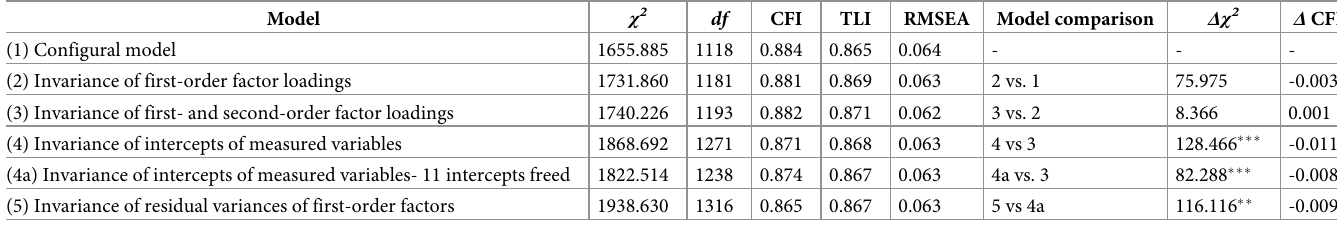
Table 3. Testing invariance of PYD scale structure by rural-urban status.